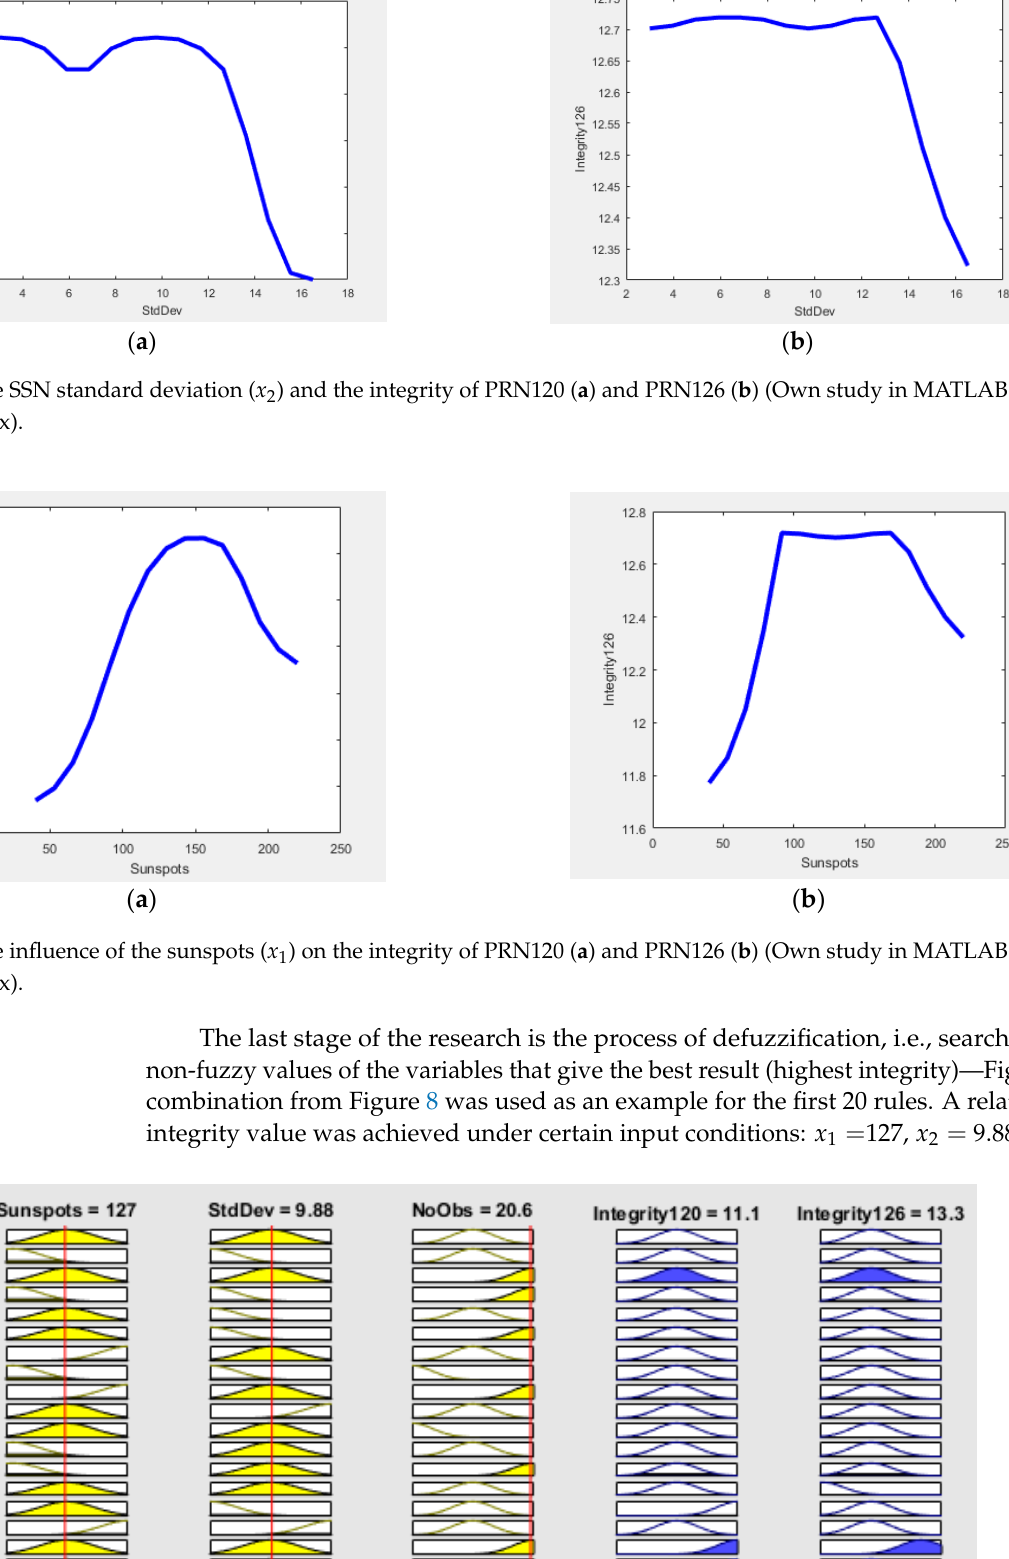
Figure 7. The influence of the sunspots ( x 1 ) on the integrity of PRN120 ( a ) and PRN126 ( b ) (Own study in MATLAB Fuzzy Logic Toolbox).